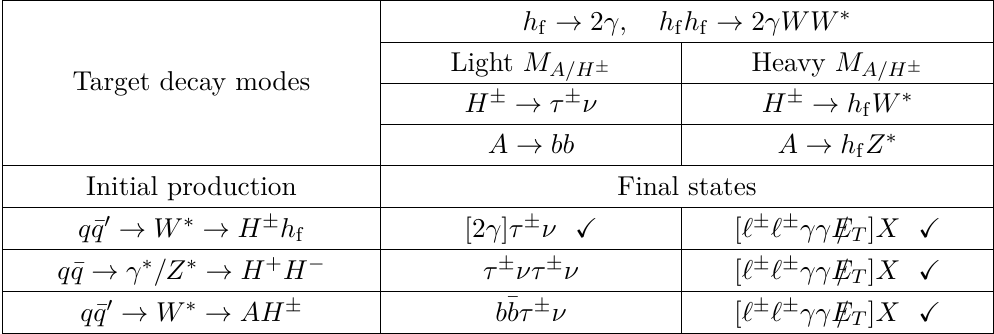
Table 2 . The production channels and final states of one or two h f at the LHC. The criteria for the light M is M m h + 15 GeV . Here ‘ ± ‘ ± ( ‘ ± = e ± , µ ± ) denotes a same-sign dilepton A/H ± H ± . f and X includes additional leptons and/or jets. The particles inside a square bracket are originated from the decay of h f or h f h f . The processes with a checkmark are expected to have a high discovery potential at the